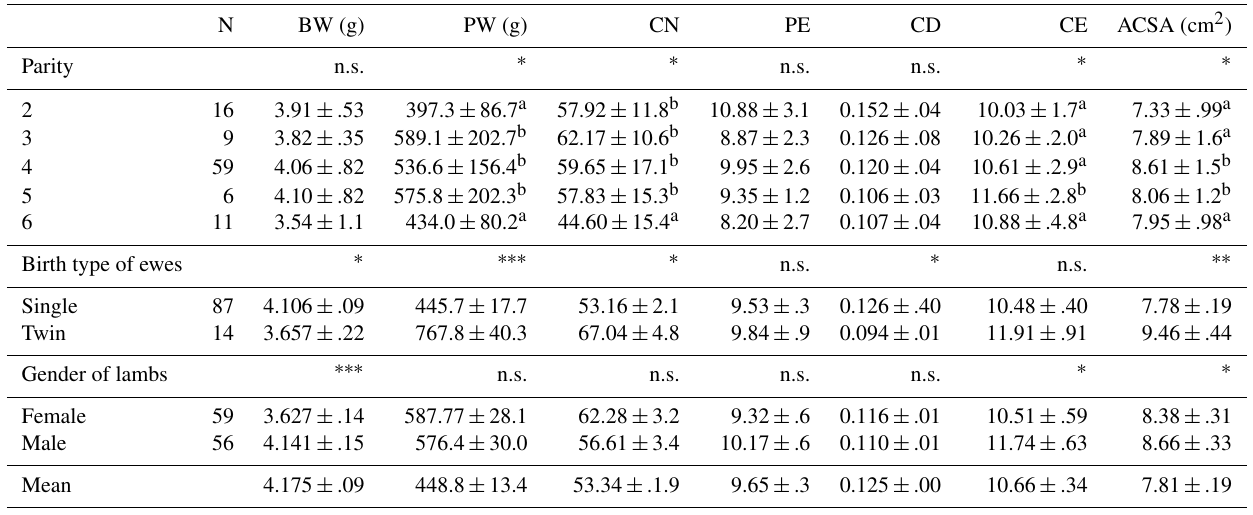
Table 1. Effect of parity, birth type and sex on placental traits ( X ± SD). N BW (g) PW (g) CN PE CD CE ACSA (cm 2 ) Parity n.s.